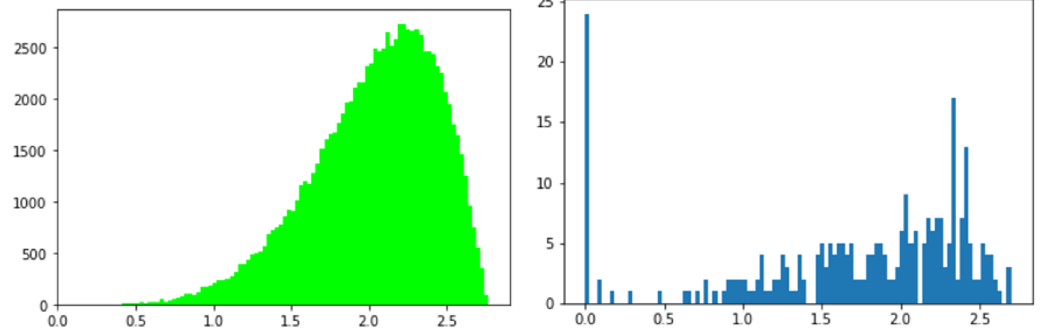
Figure 10 . Left : histogram plot on 100,000 random samples for the entropy of J with respect to the C 2 ⊗ C 2 ⊗ C 2 decomposition in su (8) . The number of bins used is 100. We note the range of [0 . 1255 , 2 . 7689] . The 0 . 1 , 0 . 5 , 1 , 5 , 10 , 25 , 50 percentiles are 0 . 6074 , 0 . 8222 , 0 . 9365 , 1 . 2822 , 1 . 4742 , 1 . 7841 , 2 . 0923 , respectively. The mean and variance are 2 . 0356 , 0 . 1618 . Right : similar to the partial decomposition, and in contrast with figure 7, we observe an extremely unlikely event for the entropy of J w.r.t. the C 2 ⊗ C 2 ⊗ C 2 decomposition, where there are 29 entries out of 282 below the 0.1 percentile of the random